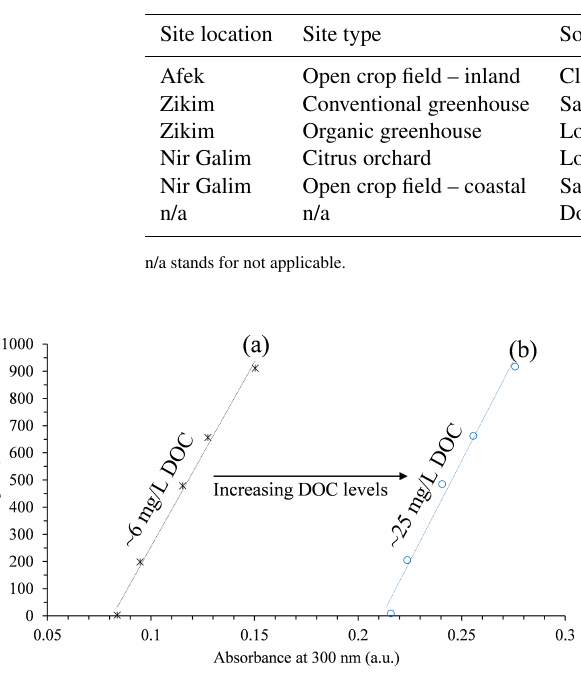
Table 1. Sampled field sites location and soil type.